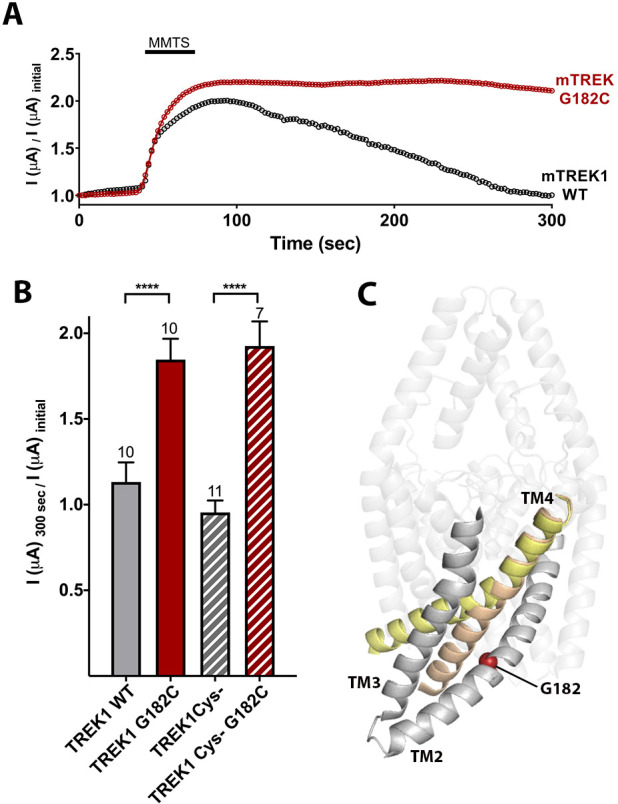
Cysteine modification at the G182 position leads to TREK1 activation.(A) Representative time courses of the response of TREK1 wildtype (WT) or TREK1 G182C channels to treatment with 2 mM MMTS. Shown is the recorded current at 0 mV holding potential, measured every 5 s for 5 min, with current values normalized to the initial value recorded at the beginning of the time course (B) Quantification of effect size at the end of the time course (300 s), for TREK1 WT and TREK1 Cys-, a mutant TREK1 channel lacking all five of the endogenous TREK1 cysteine residues, and for G182 mutants in both of the above backgrounds. Number of replicate experiments indicated. Error bars are mean ± SEM. Statistically significance determined by one-way ANOVA combined with a Sidak multiple comparison test of TREK1 WT versus TREK1 G182C and TREK1 Cys- versus TREK1 cys- G182C. Results indicated, ****p<0.0005. (C) Crystallographically defined structural models of TREK2 in the TM4 up (PDB ID 4xdl, yellow) and TM4 down (PDB ID 4bw5, tan) conformations, highlighting the TM2, TM3, and TM4 helices from only a single subunit. The position of G182 (red sphere) is noted.